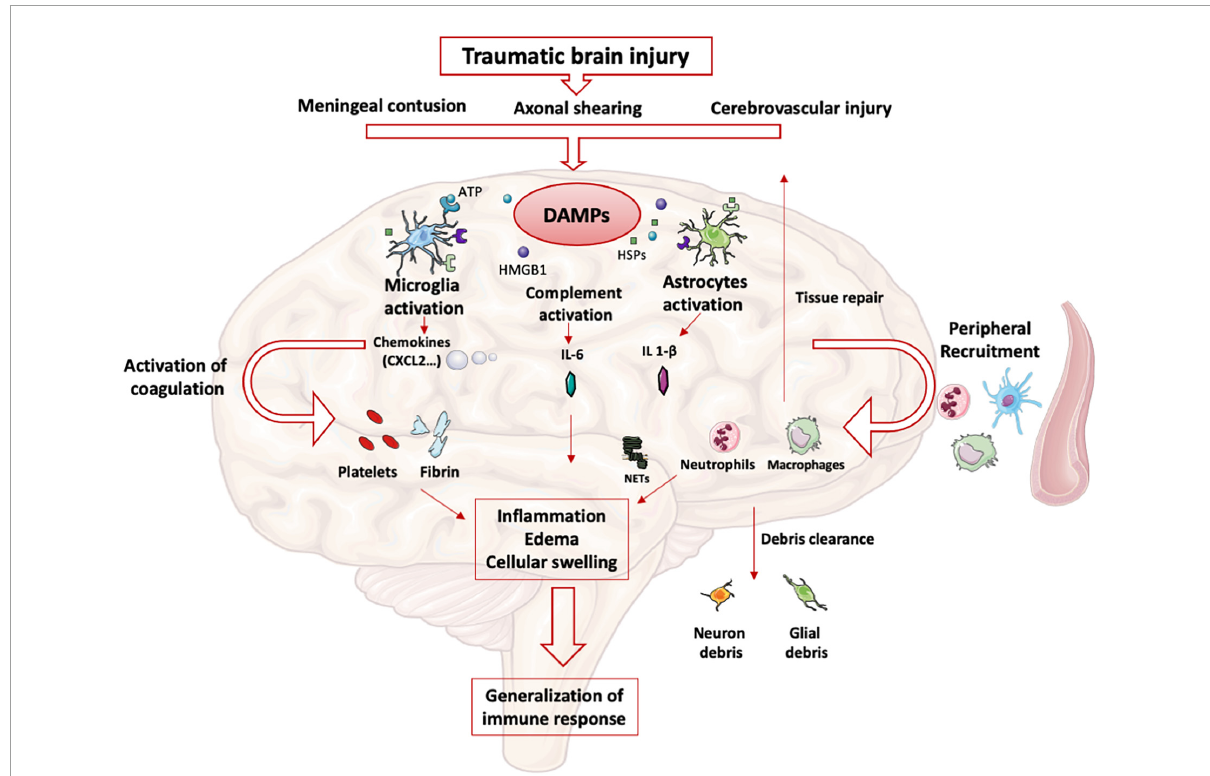
FIGURE1 Innate immune response in brain: After TBI, parenchymal, vascular, and blood-brain barrier damage results in the production of DAMPs. These DAMPs activate resident brain cells (microglia, astrocytes) that initiate the intracerebral inflammatory response. The production of cytokines and chemokines leads to the recruitment of blood leukocytes and the activation of complement and coagulation pathways. All these phenomena maintain the state of intracerebral inflammation which causes edema and induces a systematization of the immune response.